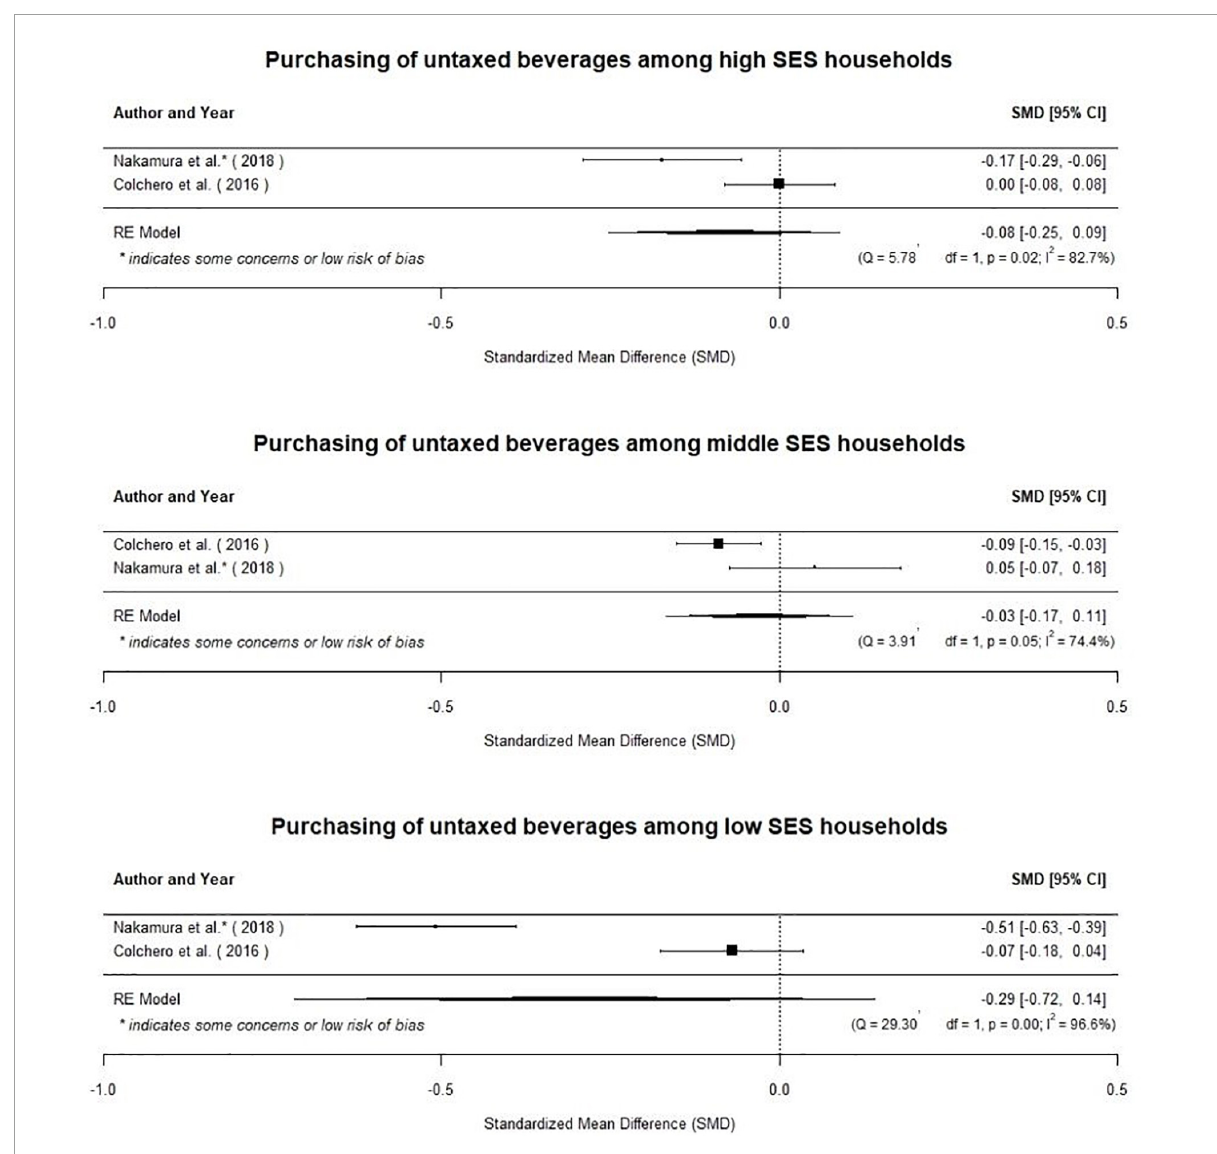
FIGURE8 The evidence base is too limited to draw conclusions about the effects of taxes by socio-economic